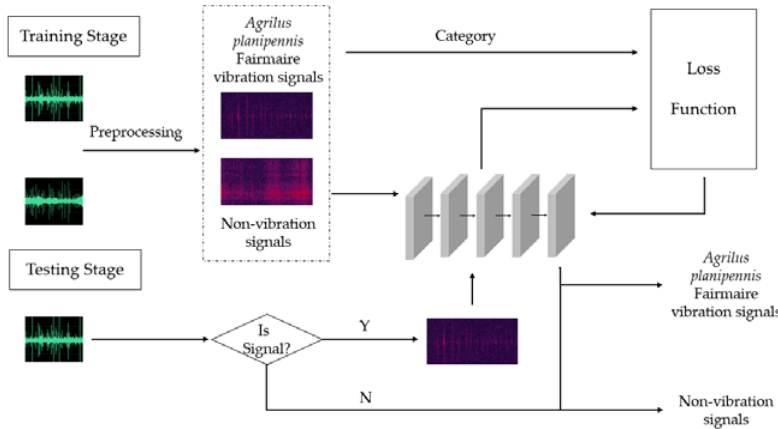
Figure 6. Flowchart of identification.